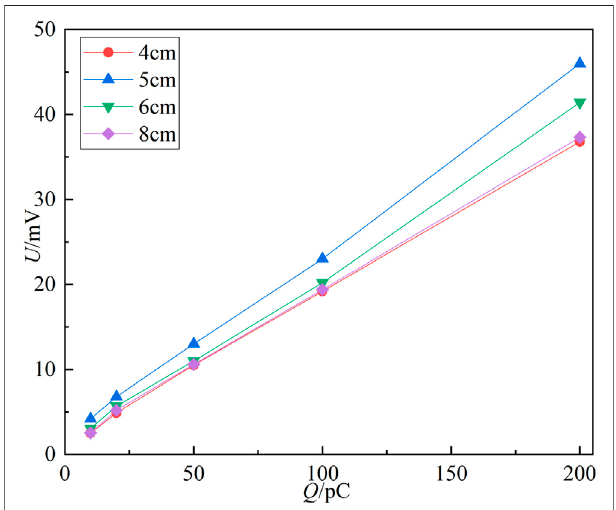
FIGURE 8 | Impulse response curves of electrode sensors with different widths.